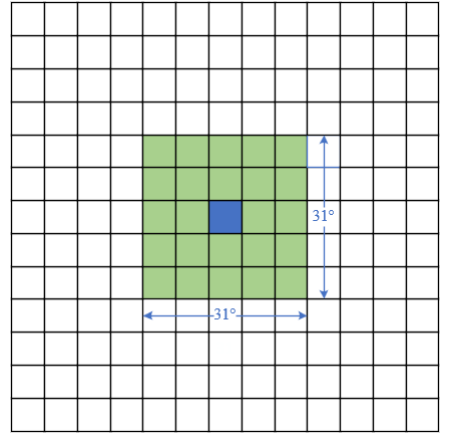
Figure 2. The 2D structure of each isobaric surface of a tropical cyclone, reprinted with permission from Ref. [19]. 2022, Springer Nature.